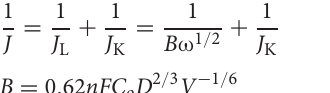
M–N of the material changes with temperature, and reaches the maximum when the temperature is 900 ◦